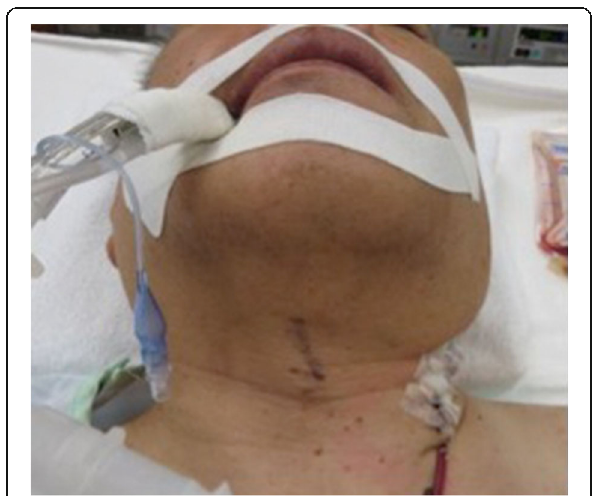
Fig. 1 Photograph showing the swelling of his neck 7 h after the